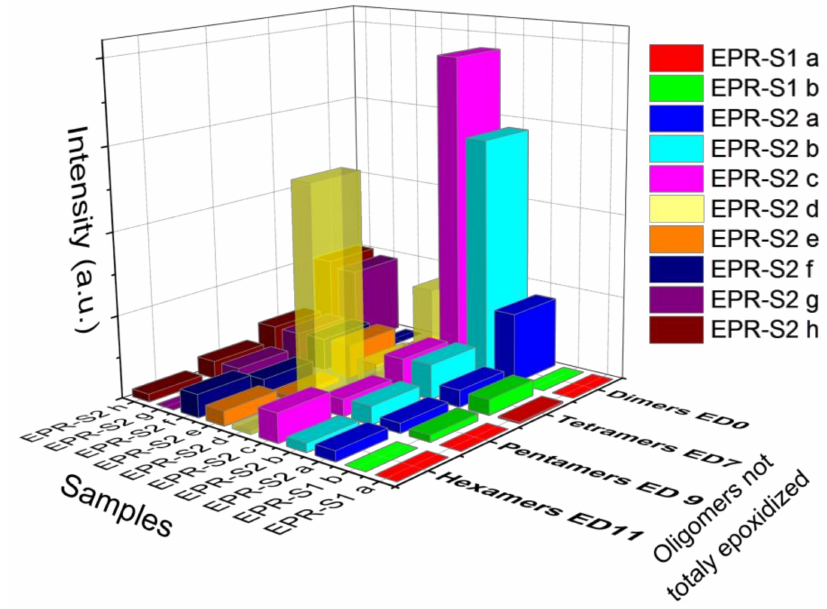
Figure 14. Compositions of not entirely epoxidized